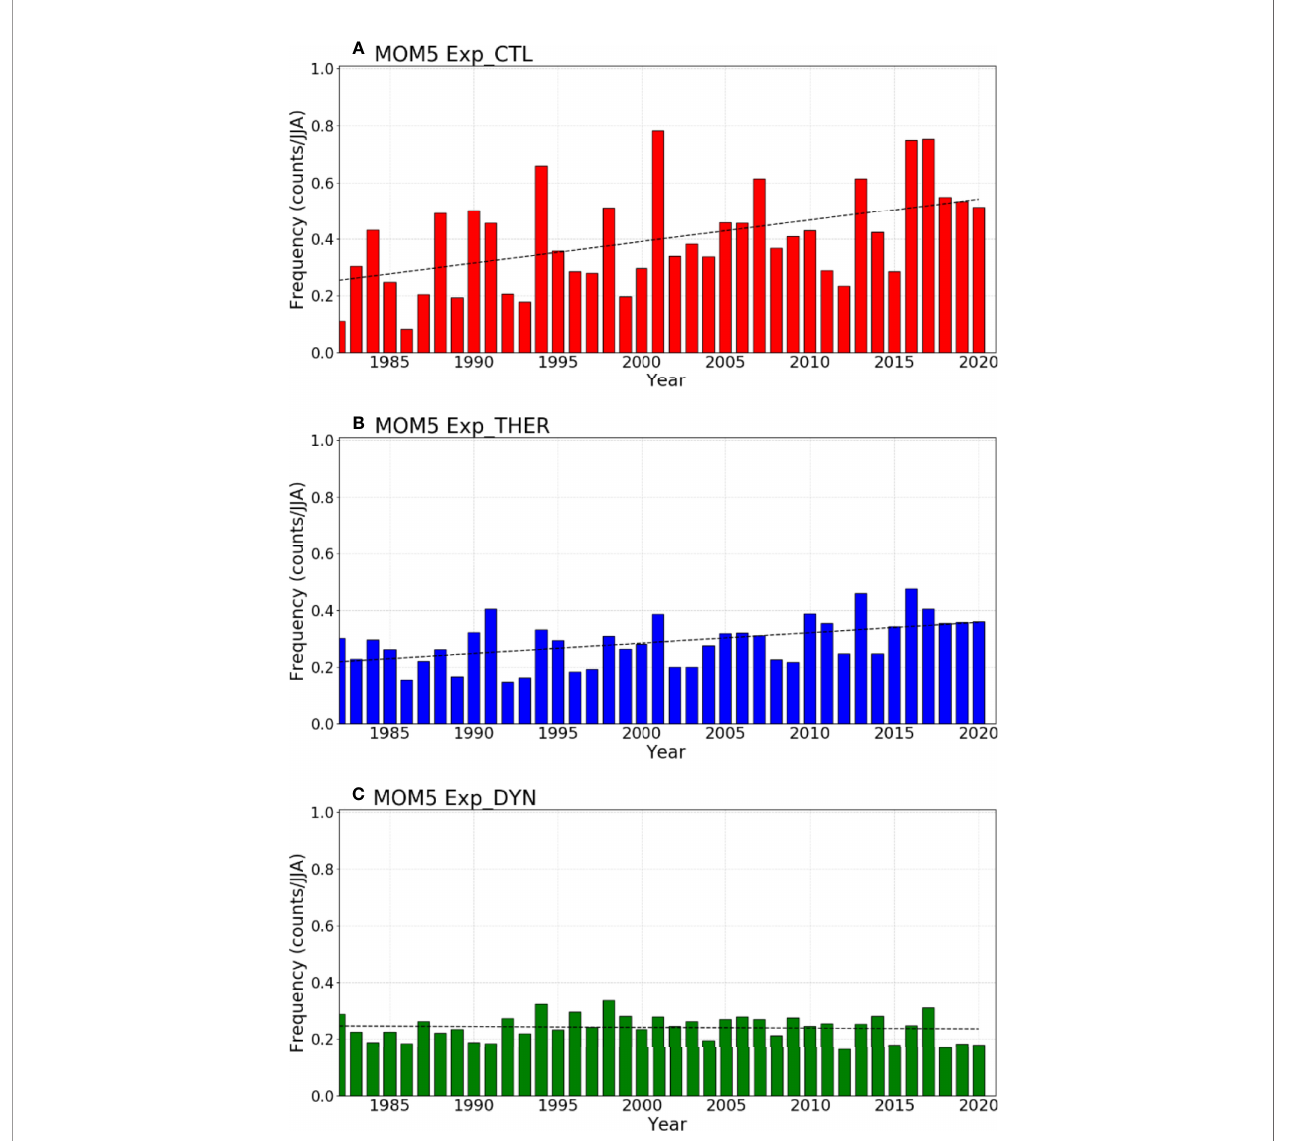
FIGURE 6 | (A) Area-average time series of the total frequency of MHW during summer in EAMS in the MOM5 Exp_CTL experiment. (B) Total frequency time series of Exp_THER as shown in (A) . (C) Total frequency time series of Exp_DYN. The 90 th percentile threshold temperature in (B, C) was de fi ned as the temperature of Exp_CTL. The black dotted line in the fi gure indicates a linear